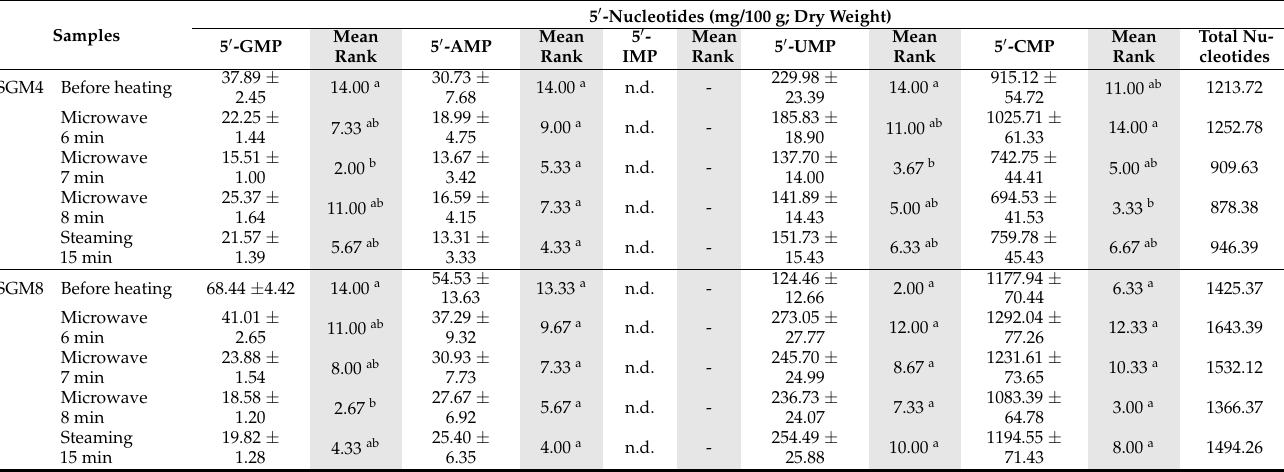
Table 2. 5 (cid:48) -Nucleotides of SGM4 and SGM8 before and after heat treatments.